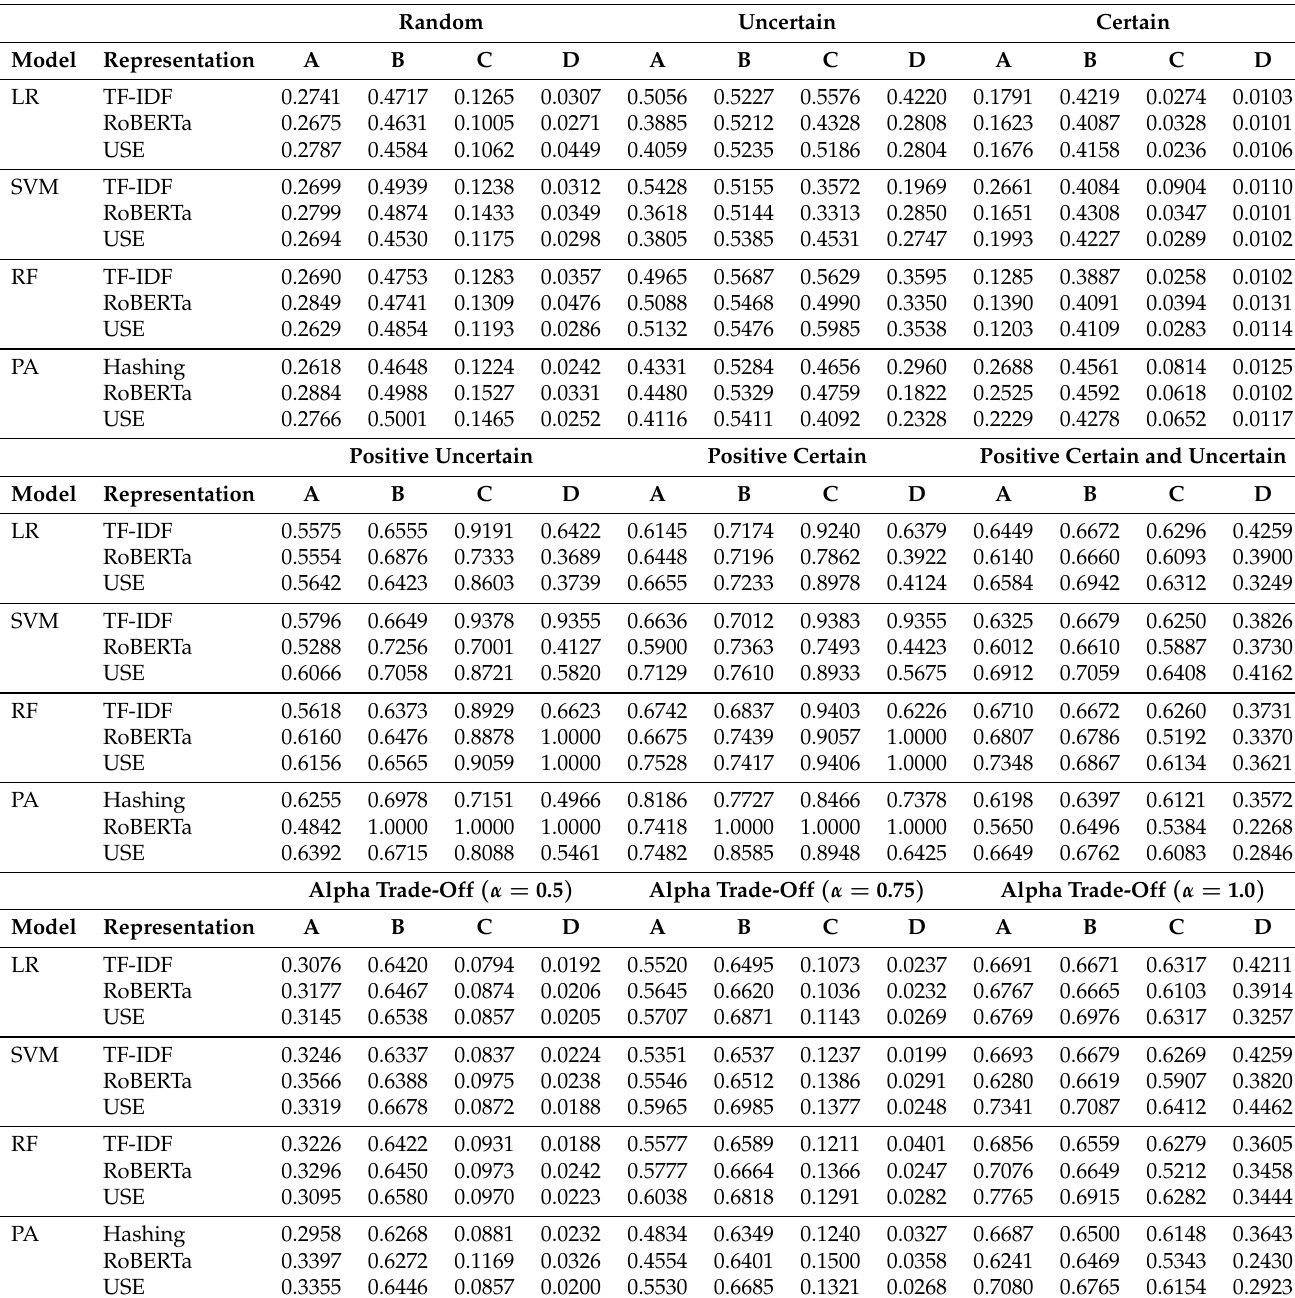
Table A3. MAP scores for all